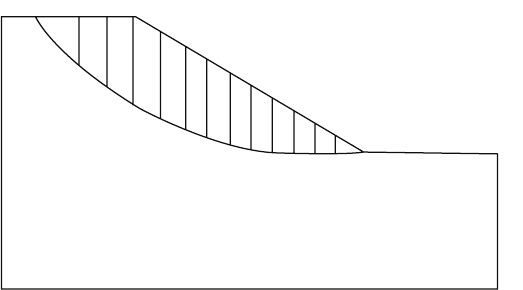
Figure 14: Hilbert spectrum of sine wave.